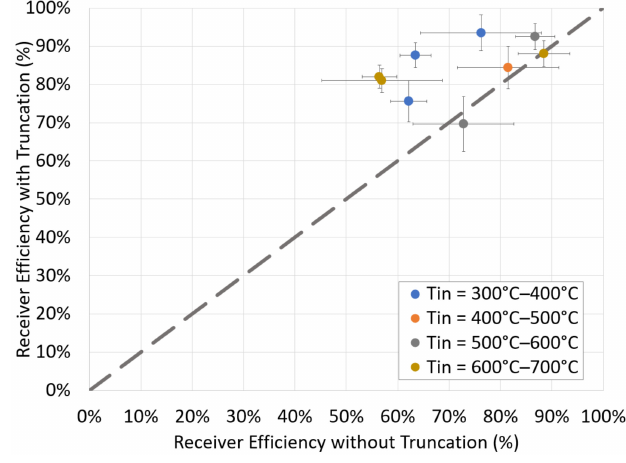
Figure 11. Parity plot comparing the receiver efficiency for previous experiments [27] and with the FPR retrofitted with a cavity truncation approximating the RVR concept [75].